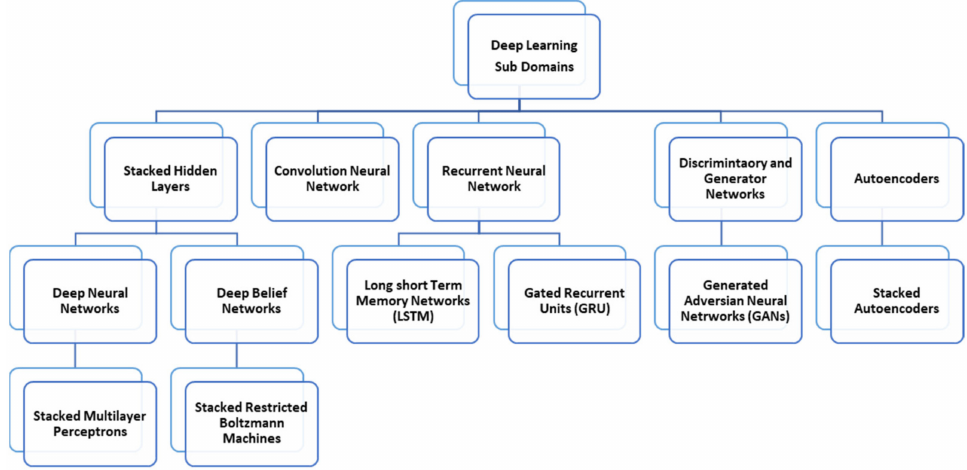
Figure 4. Types of Deep